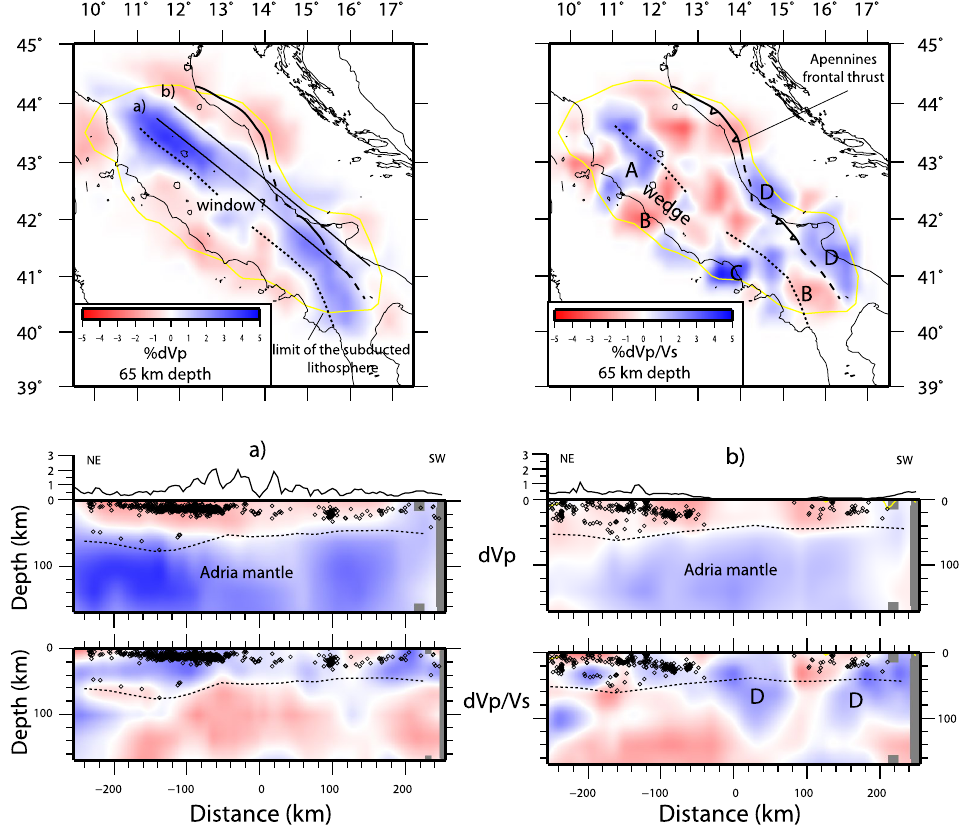
Figure 2. Vp and Vp/Vs models at 65 km depth and in two vertical sections along the Apennines slab. The main anomalies discussed in the paper are indicated by labels. Seismicity is shown in the vertical